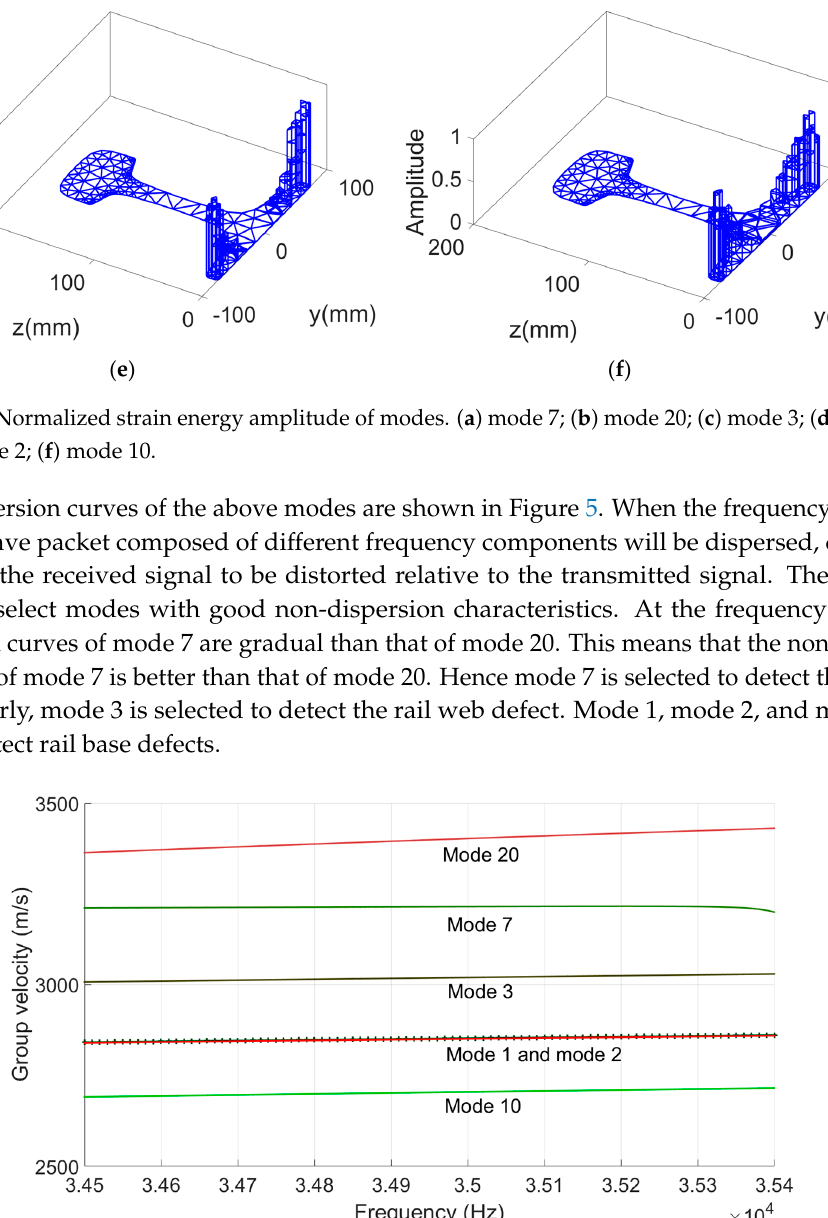
Figure 5. Group velocity dispersion curves.